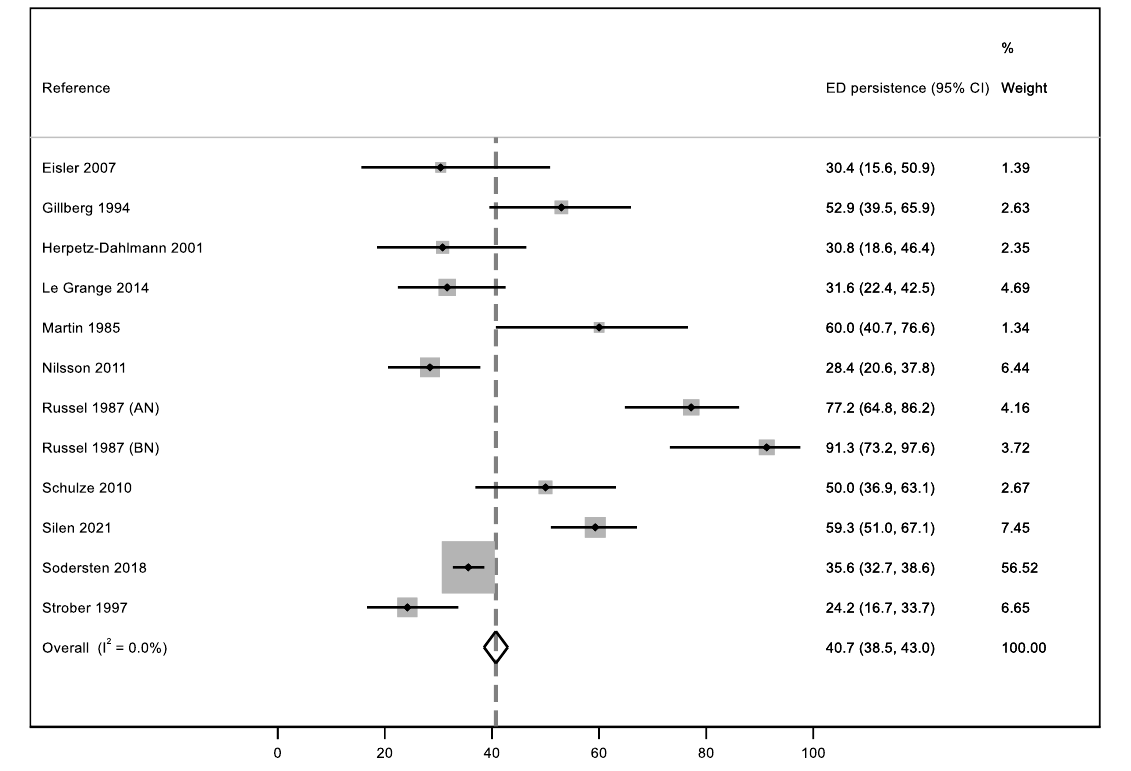
Figure 2. Meta-analysis of ED persistence in early adulthood [23,31,40,65,67,69,72 – 75,77].